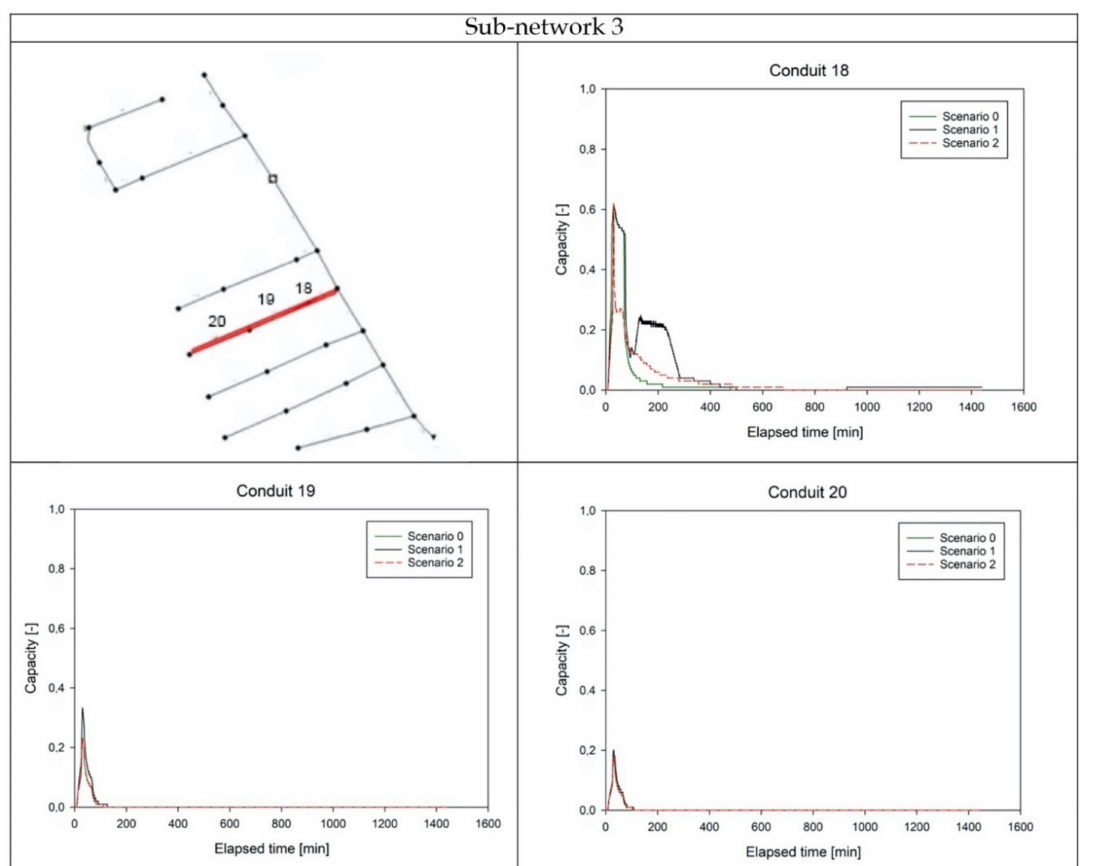
Figure A5. Conduits’ capacity in sub-network 3, highlighted in red in the first picture where the drainage network schematization is